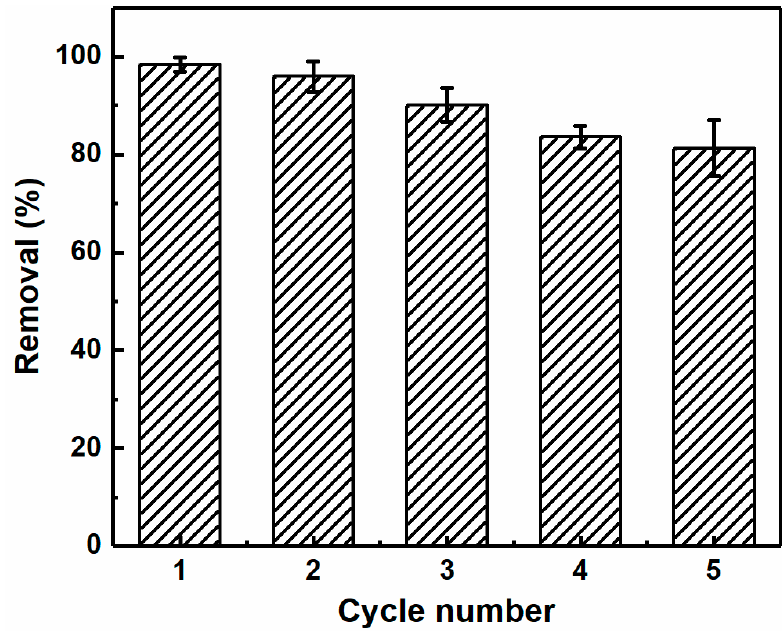
Figure 8. The removal efficiency of Pb(II) by CNC-g-P(AA/AM)-1 over five adsorption–desorption cycles.